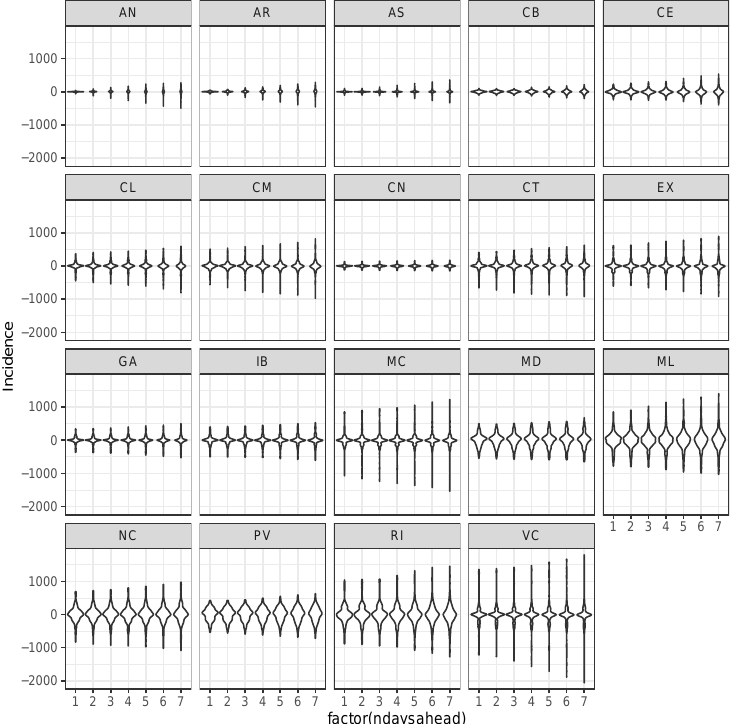
Figure A4. Violin plots of distributions of differences (cid:98) y ts − y ts conditionally to the region and the number of days ahead in the prediction using a 7th order polynomial of a Dynamic Linear